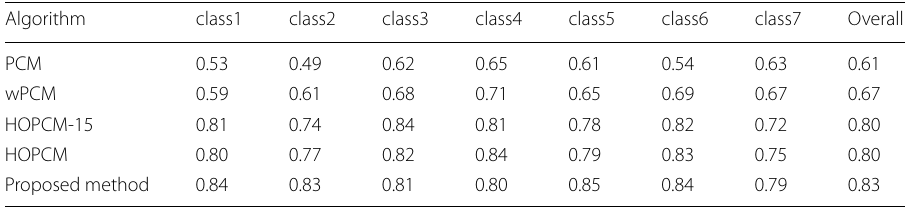
Table 6 Results of clustering quality on the MSRC-v1 dataset (ARI Score) Algorithm class1